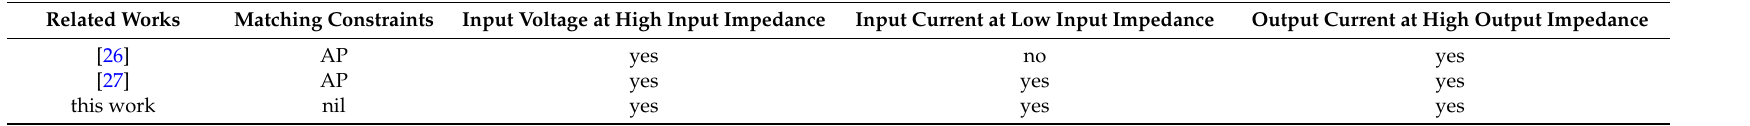
Table 4. Characteristic comparisons with previous works in [26,27].